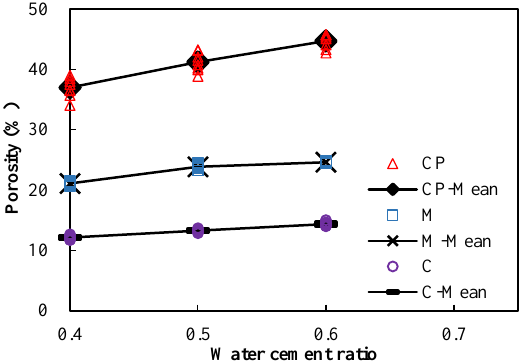
Figure 5. Porosity of undamaged specimens.